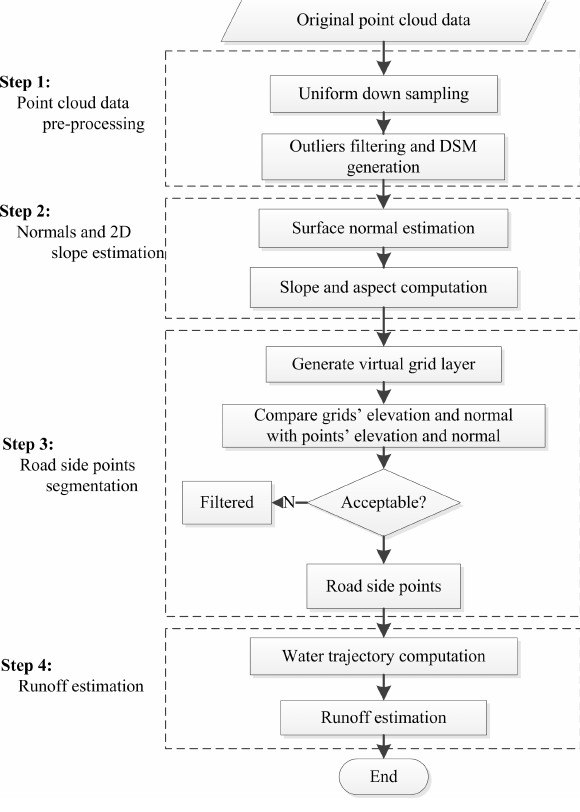
Figure 1: Method for estimation runoff from LMMS point cloud